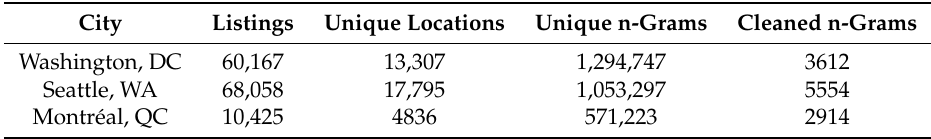
Table 1. Number of craigslist housing listings, unique housing locations, unique number of n-grams across all city listings and cleaned unique n-grams. City Listings Unique Locations Unique n-Grams Cleaned